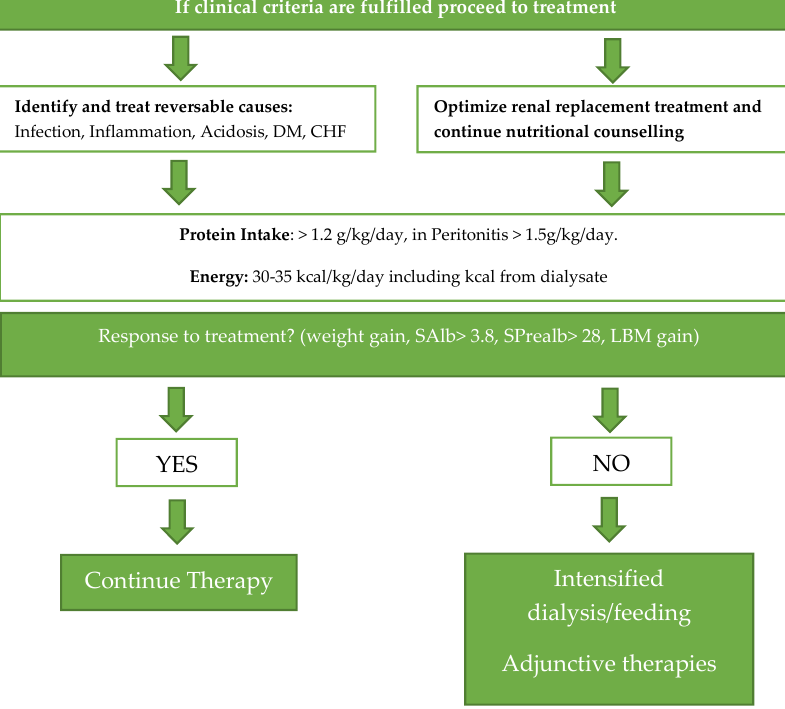
Figure 1. Assessment of nutritional status in a PD patient.